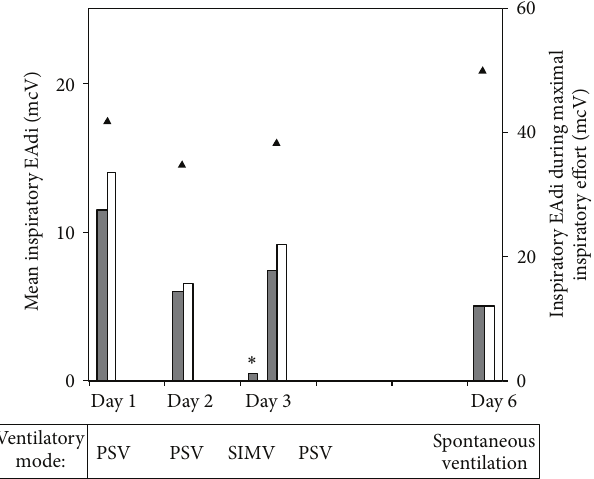
Figure 5: Daily evaluation of ventilatory drive in a 5-year-old patient with cervical myelitis. Each day, mean inspiratory EAdi was recorded during 5 minutes with the ventilation prescribed by the attending physician (grey bars) and 5 minutes under continuous positive airway pressure (CPAP, white bars). Inspiratory EAdi was also measured during 2 voluntary maximal inspiratory efforts (triangle). A period of overassistance with absent ventilatory drive was detected at day 3 ( ∗ ). The recovery of the ventilatory drive was observed rapidly after adjustment of the support. (PSV: pressure-support ventilation; SIMV: synchronized intermittent mechanical